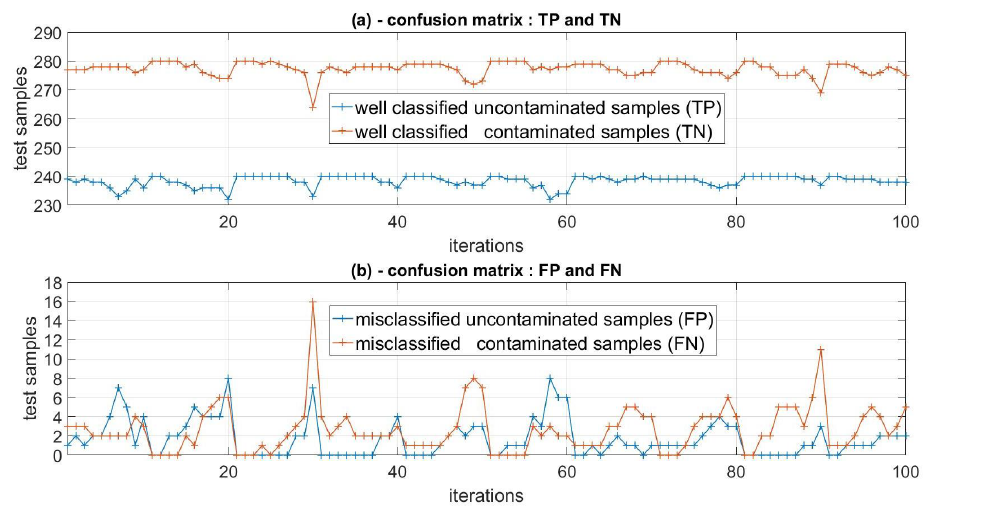
Figure 7. Confusion matrices obtained by the non-linear SVM classifier trained on Magnitude only dataset. Curve ( a ) shows the plot of the well-classified terms TP and TN, while curve ( b ) is the plot of the misclassified terms FP and